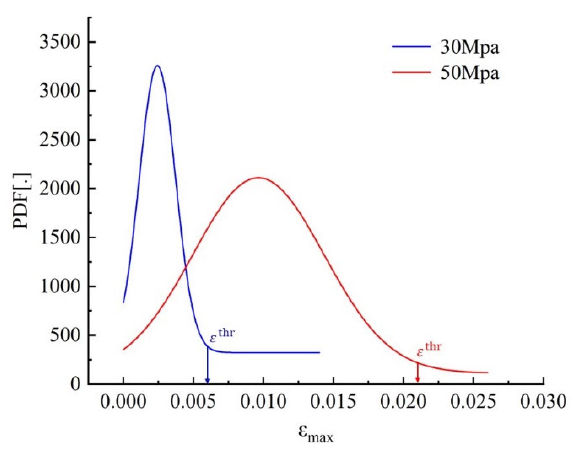
Figure 16. Probability density functions of the maximum principal strains ε max.